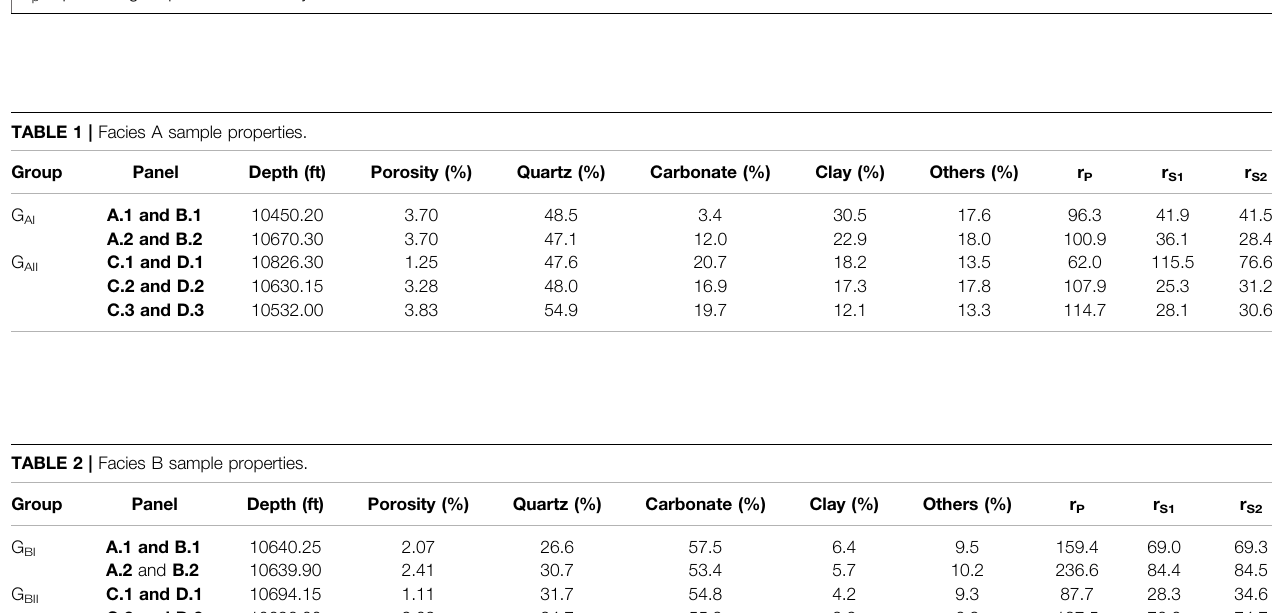
FIGURE 4 | P-wave velocity (V P ) estimation. (A) Representative ultrasonic waveforms for loading (dashed gray) and unloading (solid black) segments. The corresponding gray and black dots are the interpreted P-wave fi rst arrival times, which are then converted to V P based on known sample length and instrument calibration constants. Con fi ning pressures for individual waveforms are mentioned. (B) V P pressure sensitivity for loading (dashed gray) and unloading (solid black) segments. The thick gray line represents a function of the form V P (P C ) (cid:2) s + r P log 10 (P C ) that is fi t to the unloading cycle. For unloading segment of (A) , a high correlationcoef fi cient( R 2 (cid:2) 0.9865)isobtained.TheprocessisrepeatedforP-,S1-andS2-wavesforall23samples( SupplementaryFiguresS3 – S14 ).Ahighvalueof r p implies a higher-pressure sensitivity.